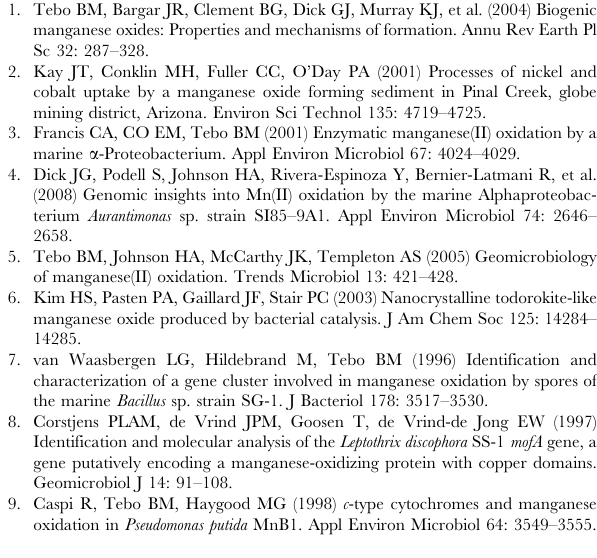
Figure S2 Illustration of the total amplified bands on the DGGE profile shown in Fig. 2. A, B, and C correspond to Figs. 3B, 3C, and 3D, respectively. (TIF) Figure S3 Average diversity index of Mn(II)-enriched soil samples calculated from B , C , and D in Fig. 5. (TIF) Figure S4 Two-dimensional plots of the MDS analysis results of the DGGE patterns of Mn(II)-enriched soil samples from different depths (represented by A, B, and C) in Figs. 2 B, C, and D . e , original soil; N , 0 mM Mn(II)-enriched soil; & , 1 mM Mn(II)- enriched soil; and m , 10 mM Mn(II)-enriched soil. (TIF) Figure S5 SEM images of the mixture of bacteria and Mn oxides as well as EDX spectra of the corresponding selected areas. A86, B159, and C19 illustrate the formation of Mn oxide aggregates; C13 represents a sample without the formed Mn oxide aggregates. (TIF) Table S1 Summary of the 16S rRNA gene sequences obtained from the predominant bands in the DGGE gel from different soil horizons and the closest match to the NCBI nucleotide sequence database (GenBank) a